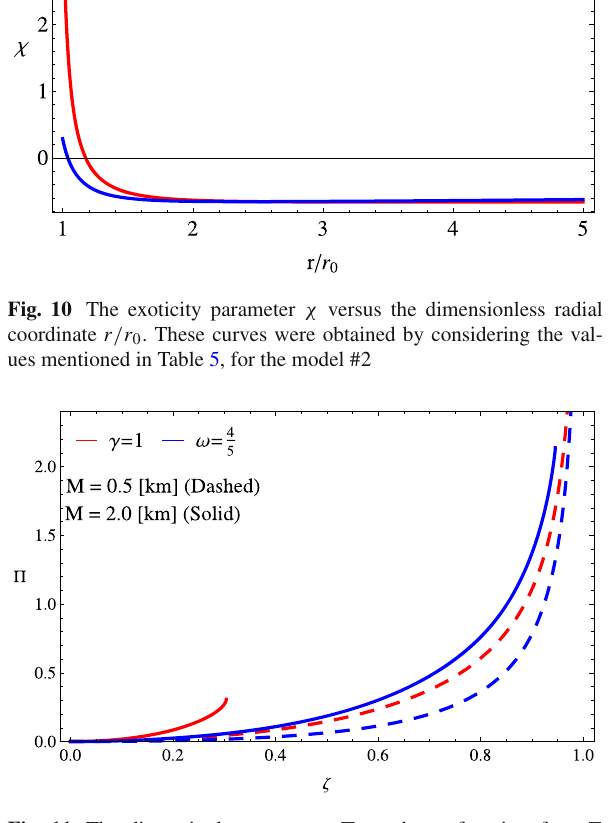
Fig. 11 The dimensionless pressure Π on the surface interface Σ against the dimensionless parameter ζ . These curves were obtained by ;− 3 . 450 ; 1 ( km ) ; 1 . 05 ( km ) } ,forthethe considering { ω ; α ; r 0 ; r ∗ = { 4 5 model #1 and { γ ; α ; r 0 ; r ∗ = { 1 ; 1 . 265 ; 1 ( km ) ; 2 ( km ) } for the model